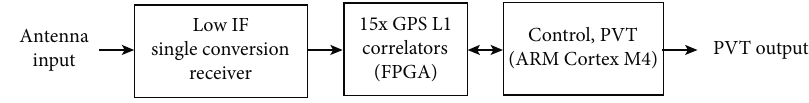
Figure 5: Block diagram of piNAV GPS receiver.